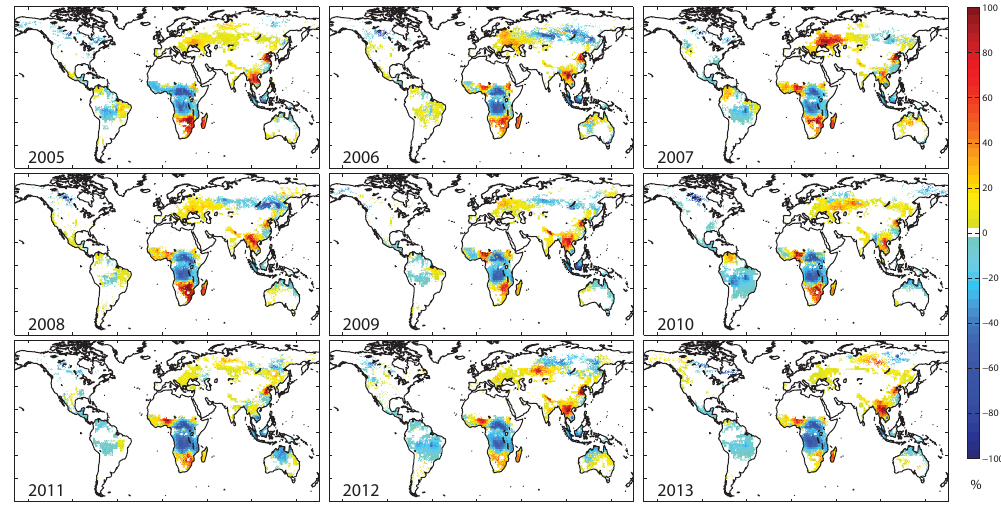
Figure 5. Updates (percentage change from the a priori) in annually averaged biomass burning emissions suggested by the flux inversion for all years of the study period.